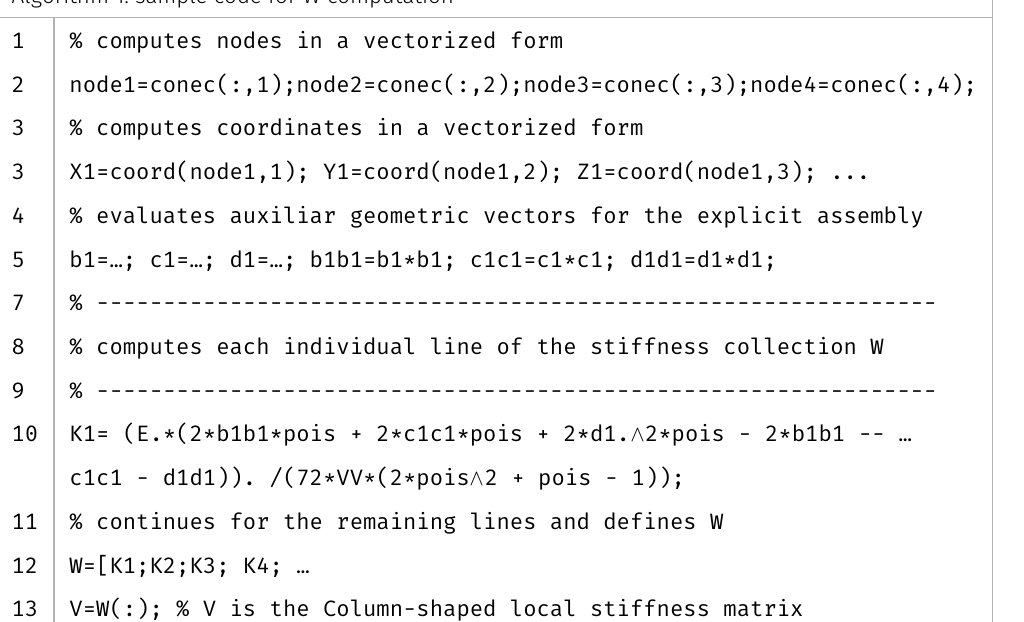
Algorithm 1: sample code for W